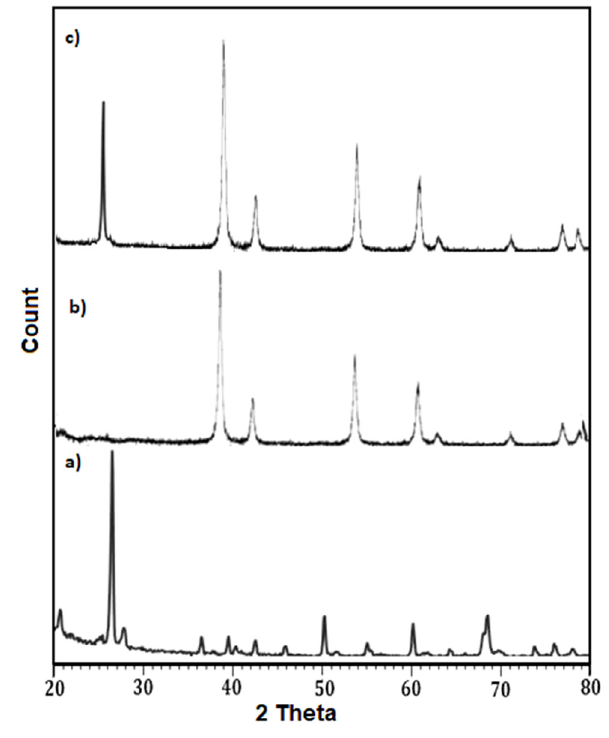
, b) SiO c) CeO :SiO composite 2 2, 2 2